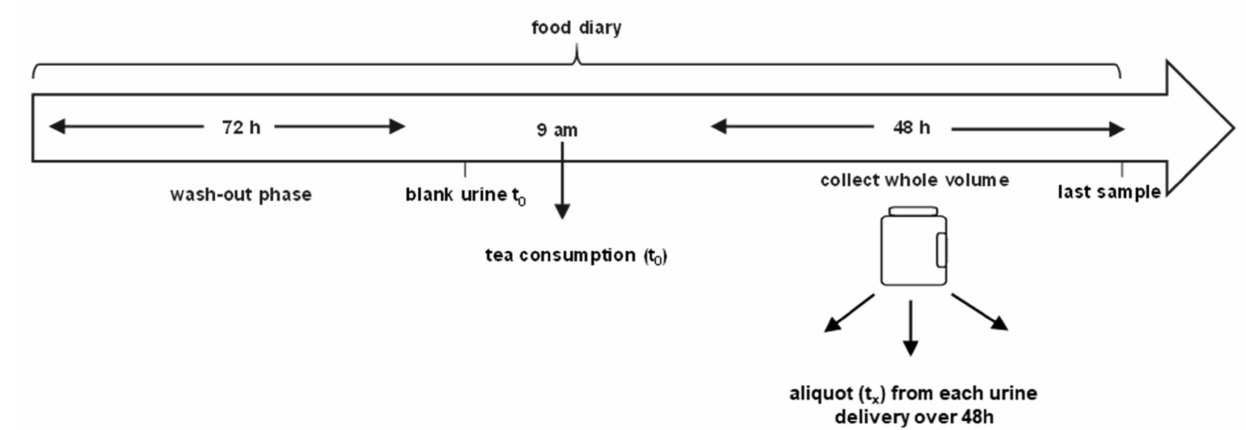
Figure 1. Study design including wash-out phase, diary keeping and urine collection after intake of 300 mL calamus tea infusion. Urine samples were collected for 48 h and total urine volume was determined. The participants collected a spot urine sample every time they